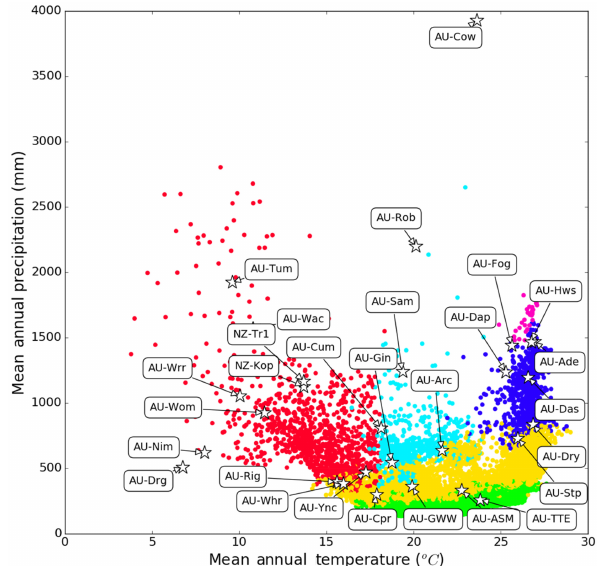
Figure 2. OzFlux sites (white stars) across bioclimatic space with Fluxnet codes (Table 1). Mean annual temperature and mean an- nual precipitation are shown as the climate space using mean annual (1961–1990) gridded data (0.1 ◦ resolution) (Bureau-of- Meteorology, 2013). The colours represent the major modified Köp- pen climate classes (Stern and Dahni, 2013) as follows: (1) equa- torial (pink), tropical (dark blue), sub-tropical (light blue), desert (green), grassland (yellow), and temperate